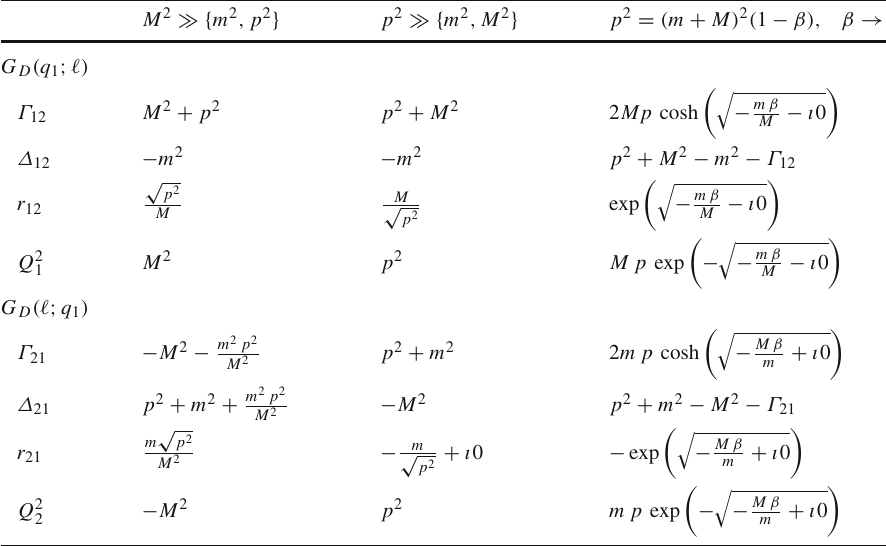
M 2 (cid:11) { m 2 , p 2